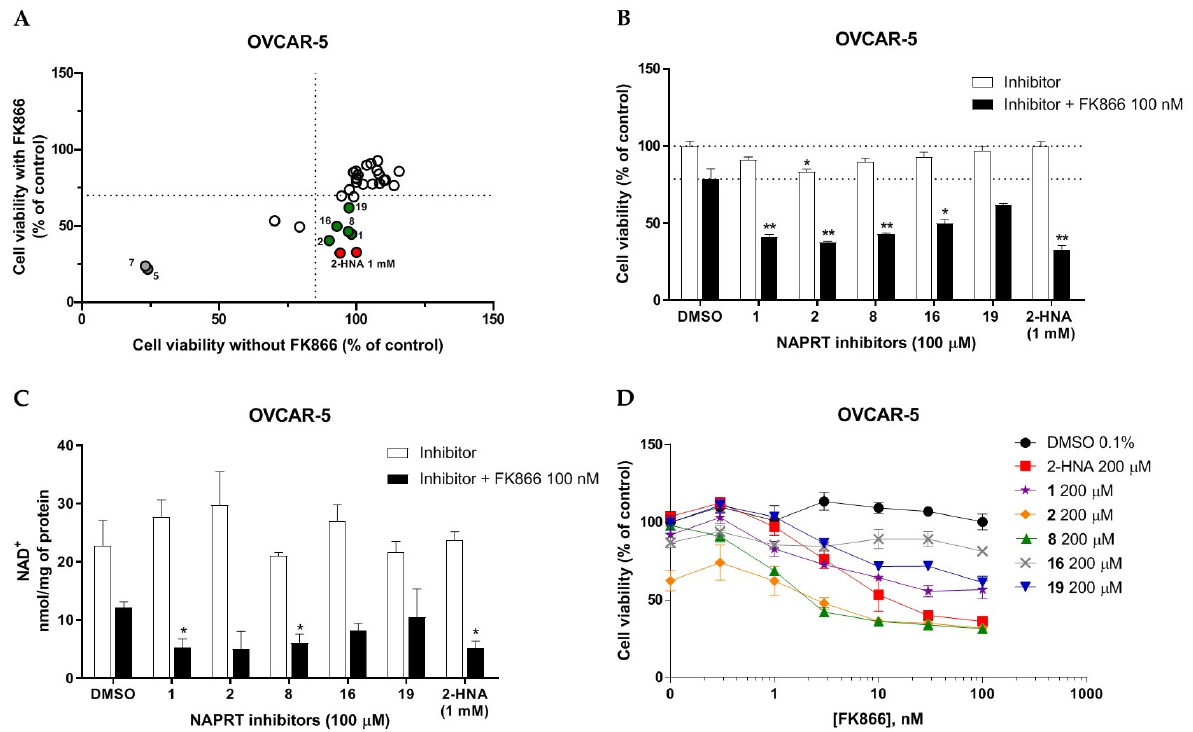
Figure 5. In vitro screening of the putative NAPRT inhibitors. ( A ) Graphical representation of the cell viability results obtained from screening our selected compounds in ovarian cancer cells. OVCAR-5 cells were plated in 96-well plates (2 × 10 3 cells/well) and left to adhere overnight. The following day, the culture media were replaced with new media containing the respective treatments (i.e., with or without 100 nM FK866 and the putative NAPRT inhibitors, all at 100 µ M final concentration, except for 2-HNA, which was used at 1 mM). Each point is the mean of three experimental replicates normalized to the control. The green circles indicate the five most promising putative inhibitors, and the red circles represent 2-HNA as the control NAPRT inhibitor. ( B ) The viability results for the five most-promising NAPRT inhibitors from ( A ) are also represented in a bar graph. * , p < 0.05; **, p < 0.01 ( C ) OVCAR-5 cells were plated in 12-well plates (1 × 10 5 cells/well) and allowed to adhere overnight. The following day, the culture media were replaced with new media containing the respective treatments (i.e., with or without 100 nM FK866 and the putative NAPRT inhibitors, all at 100 µ M final concentration, except for 2-HNA, which was used at 1 mM). After 24 h, intracellular NAD levels were measured. *, p < 0.05 ( D ) OVCAR-5 were plated in 96-well plates (2 × 10 3 cells/well) and allowed to adhere overnight. The following day, the culture media were replaced with new media that contain the respective treatments (i.e., with or without FK866 at increasing concentrations from 0.3 to 100 nM and the putative NAPRT inhibitors, added at 200 µ M final concentration), and sulforhodamine B